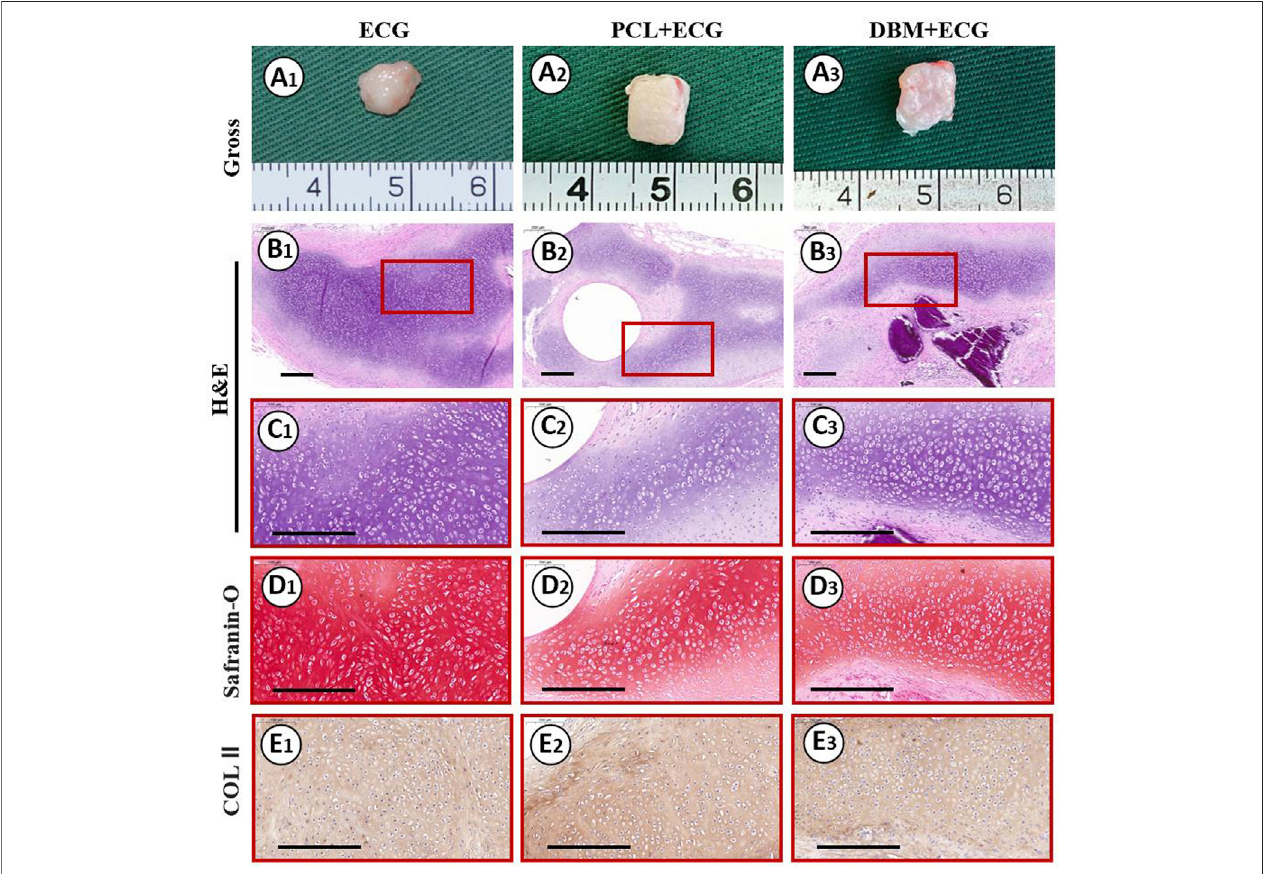
FIGURE 8 | Gross view and histological examinations of the regenerated cartilage in ECG, PCL-ECG, and DBM-ECG groups after 8 weeks of subcutaneous implantation:Grossobservation (A1 – A3) ;H&Estainingwithdifferentmagni fi cation (B1 – B3,C1 – C3) ;Safranin-Ostaining (D1 – D3) ;COLIIimmunohistochemicalstaining (E1 – E3) . Scale bar: 200 μ